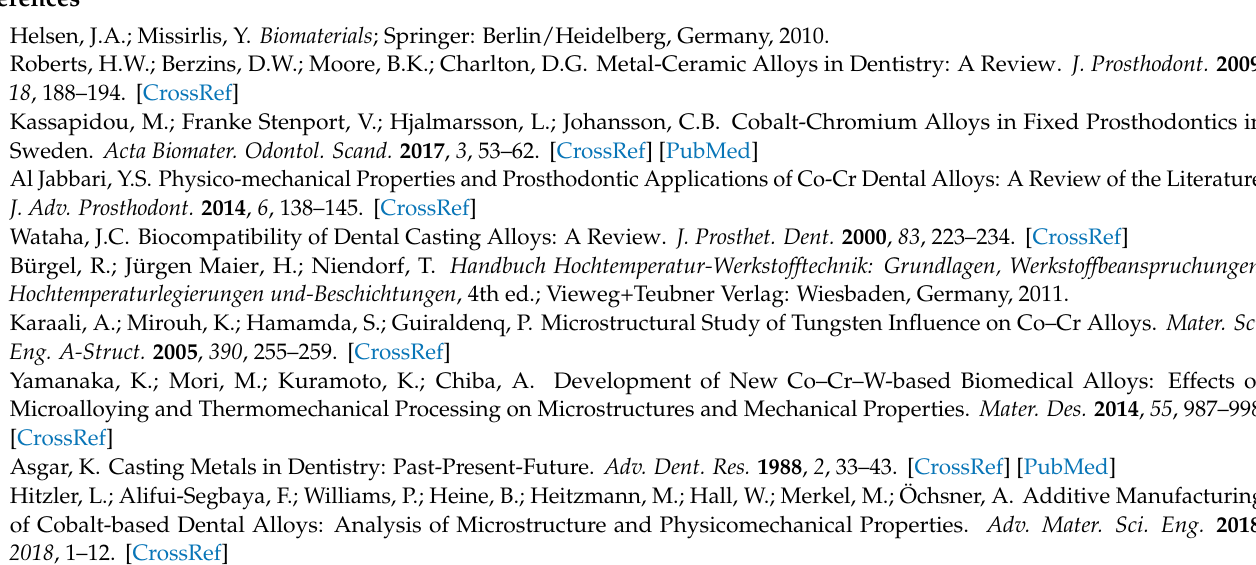
Figure A4. Estimated FWHM of the Lorentzian component function fitted to the ( 111 ) - γ -peak over the time spent in the HT measured with in-situ XRD. Values for samples 1 and 2 could not be given due to peak overlap with ( 002 ) - (cid:101)